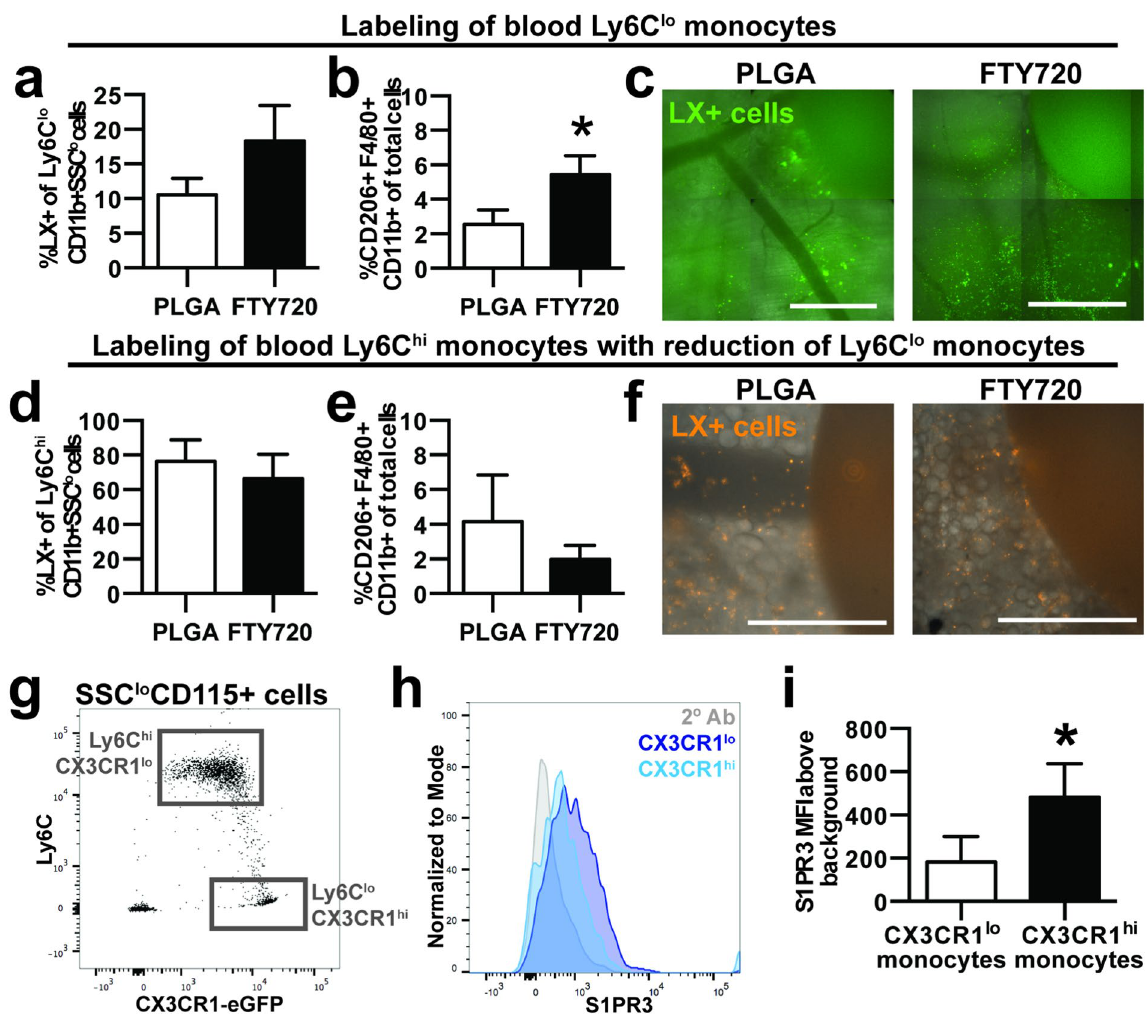
Figure 5. On-site delivery of FTY720 recruits blood-derived non-classical monocytes and increases the frequency of alternatively activated macrophages. PLGA films loaded with FTY720 were implanted immediately after DWC surgery. ( a ) Proportion of latex bead-positive (LX + ) Ly6C lo monocytes that were derived from blood in tissue 3 days post-injury following labeling of Ly6C lo monocytes. ( b ) Overall frequency of CD206 + F4/80 + CD11b + macrophages in the presence of FTY720. ( c ) LX + cells in tissue surrounding unloaded or FTY720-loaded PLGA implants. ( d ) Proportion of LX + Ly6C hi monocytes that were derived from blood following labeling of Ly6C hi monocytes with Clod Lip. ( e ) Overall frequency of CD206 + F4/80 + CD11b + macrophages in the presence of FTY720 after Clod Lip administration. ( f ) LX + cells in tissue surrounding unloaded or FTY720-loaded PLGA implants. ( g ) Ly6C expression in CX3CR1 hi monocytes and CX3CR1 lo monocytes obtained from the blood of CX3CR1 GFP/ + mice identify Ly6C lo monocytes and Ly6C hi monocytes, respectively. ( h,i ) Surface S1PR3 expression in blood CX3CR1 hi cells and CX3CR1 lo cells. To control for background staining, CX3CR1 GFP/ + cells were stained with secondary antibody (2° Ab) only, which is shown in the gray histogram. Scale bars, 500 µ m. Data presented as mean ± S.E.M. Statistical analyses were performed using two-tailed t-tests. * p < 0.05, n = 4–10 animals per